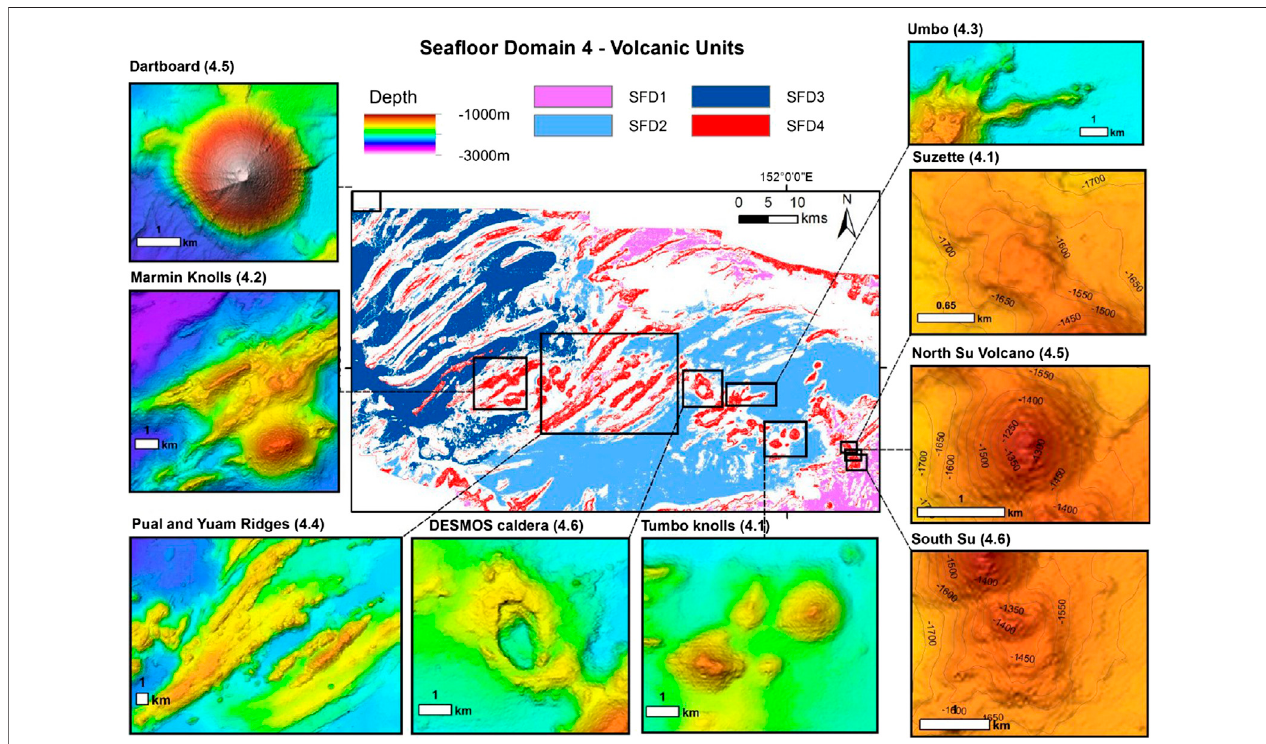
FIGURE 6 | Examples of volcanic edi fi ces within SFD4 and their distribution across the EMB. Known and surveyed volcanic features are used here as examples with the names and Type 4 subclass shown in brackets. White scale bar for inset images represents 1 km. Base layer represents BTM results from Figure 4 . More detailed information is given in Supplementary Table S2 .